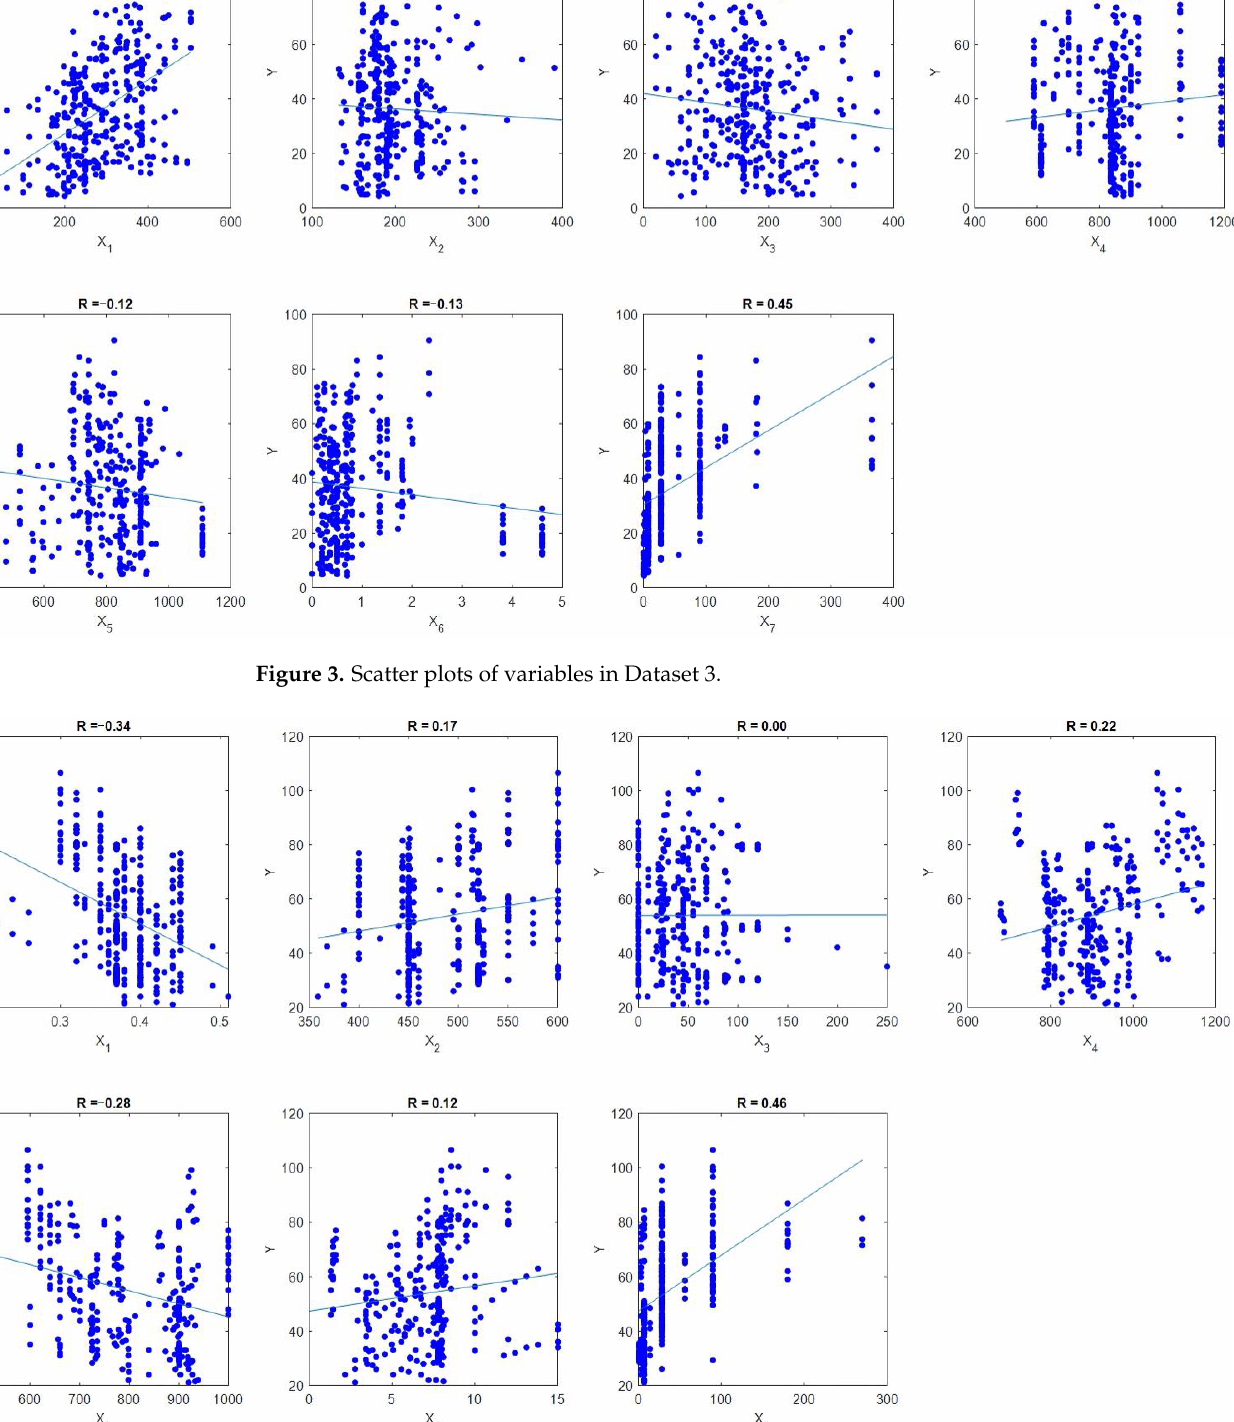
Figure 4. Scatter plots of variables in Dataset 4.